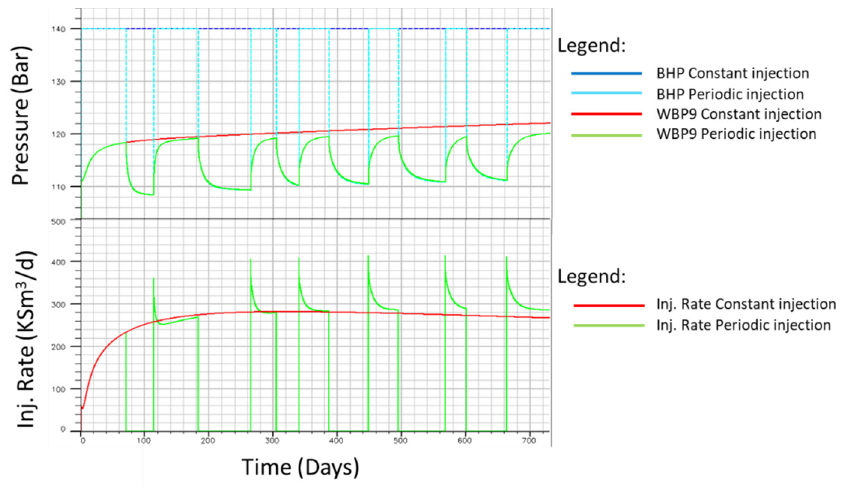
Figure 24. Bottom hole (BHP) and average near-well (WBP9) pressures and injection rates in the cases of continuous and periodic injection with varying injection and shut-in lengths.